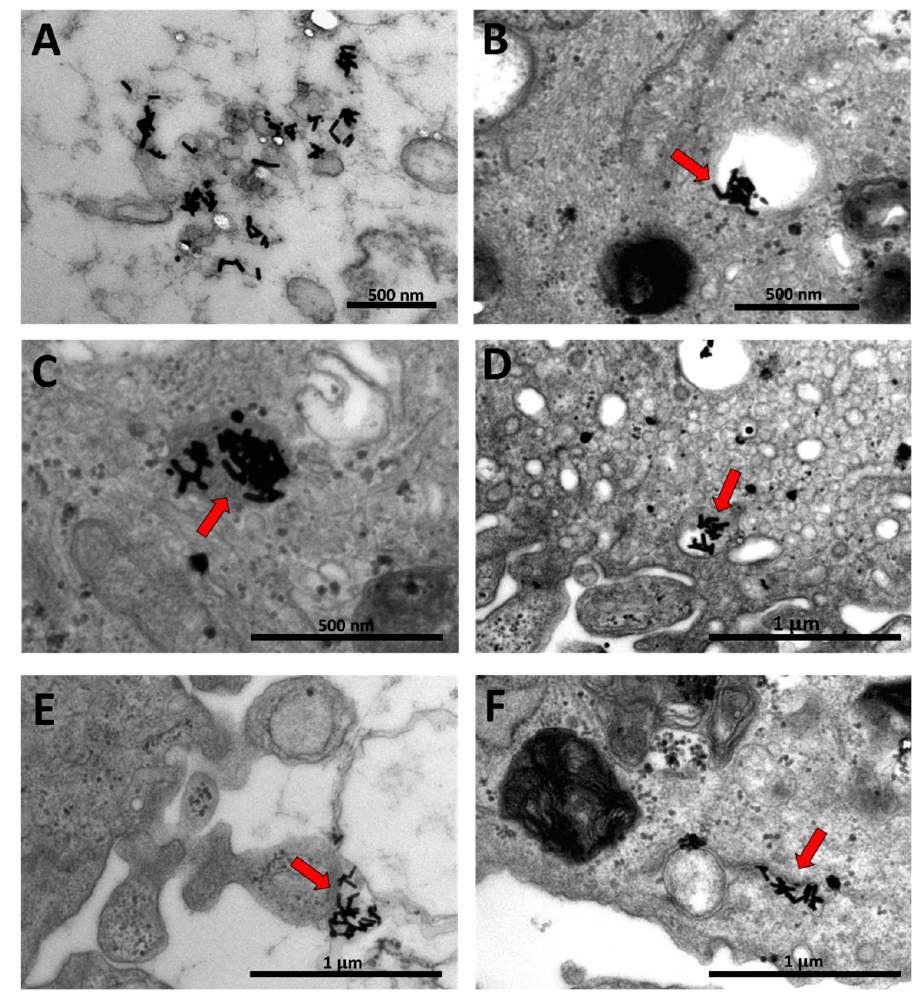
Figure 4. TEM images of human dermal fibroblasts upon treatment with PAA-GNR. Individuals and clusters of nanorods were accumulated into di ff erent regions of the cells; into the cytoplasm ( A , C , F ), into the vacuoles ( B , D ) and at the cell membrane ( E